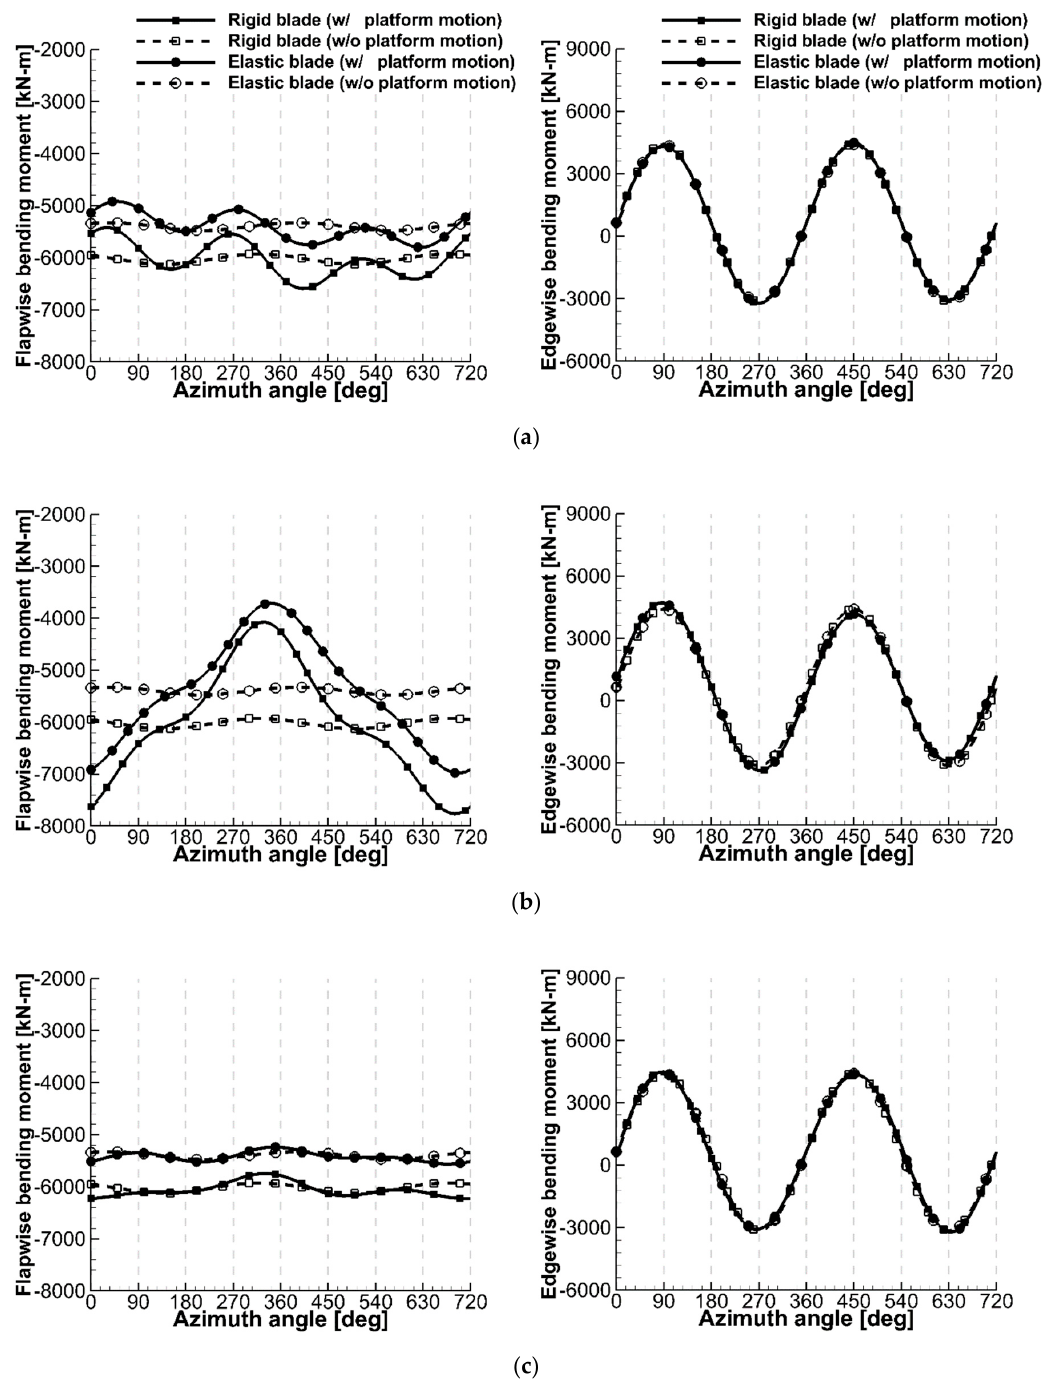
Figure 16. Blade root bending moments under rotational platform motions. ( a ) Yaw motion. ( b ) Pitch motion. ( c ) Roll motion.